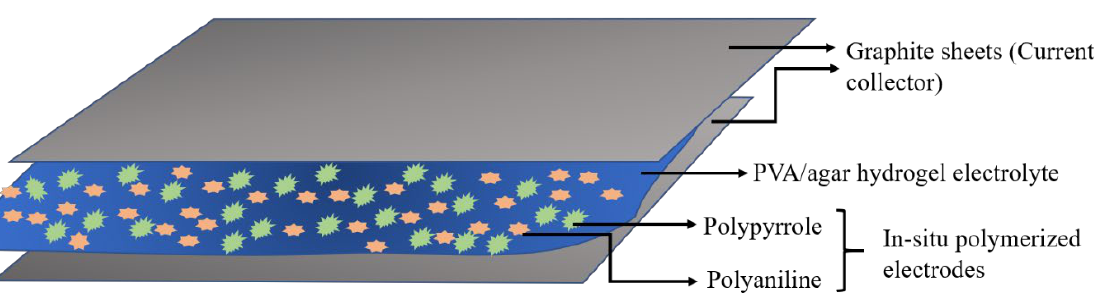
Figure 2. Graphical illustration of the fabricated all-in-one configuration supercapacitor cell.